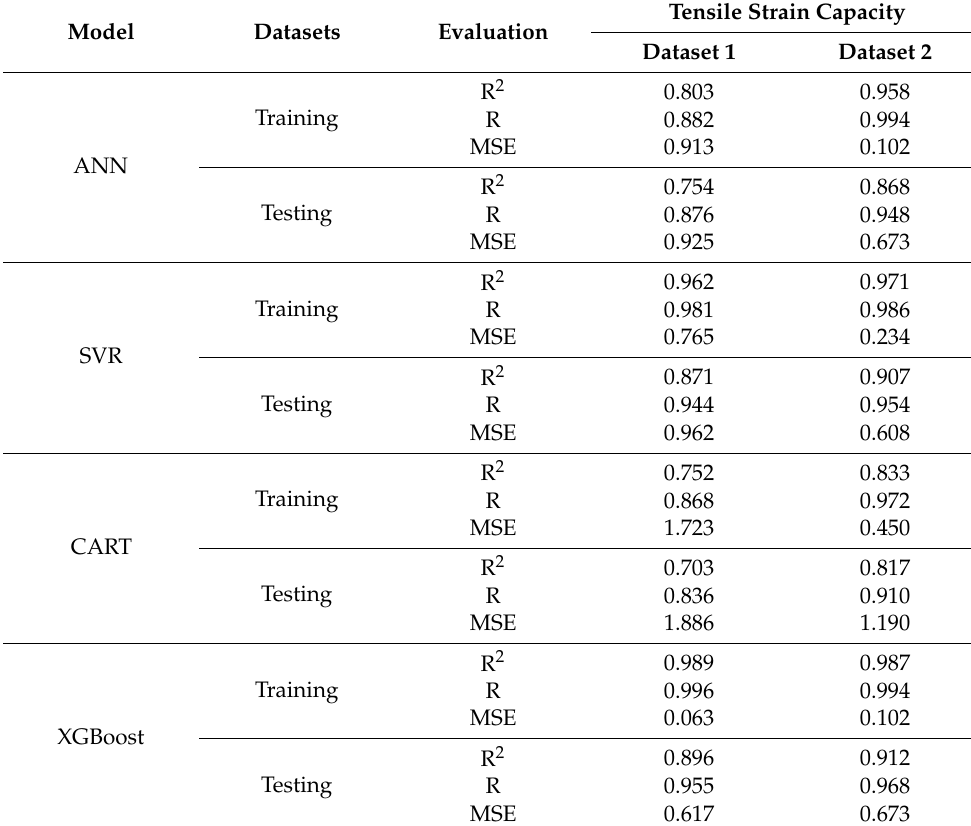
Table 6. Evaluation of prediction results using enlarged